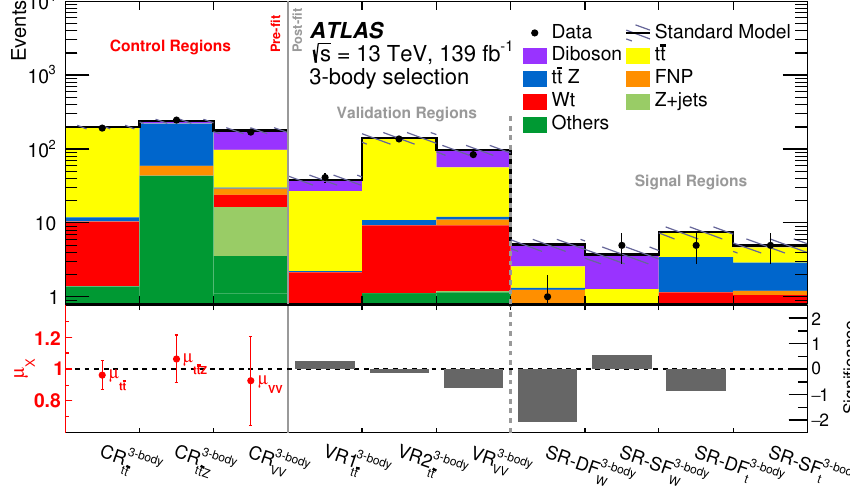
Figure 9 . Three-body selection. Expected and observed yields are shown. The upper panel shows the observed number of events in each of the CRs, VRs and SRs defined in the three-body selection, together with the expected SM backgrounds obtained before the fit in the CRs and after the fit in the VRs and SRs. “Others” includes contributions from V V V , tt t , tttt , tt W , tt WW , tt WZ , tt H , and tZ processes. The shaded band represents the total uncertainty in the expected SM background. The lower panel shows the normalisation factors µ (left three bins) extracted in X the CRs for the tt , tt Z and diboson processes, while, for the VRs and the SRs (right bins), the significance as defined in ref.